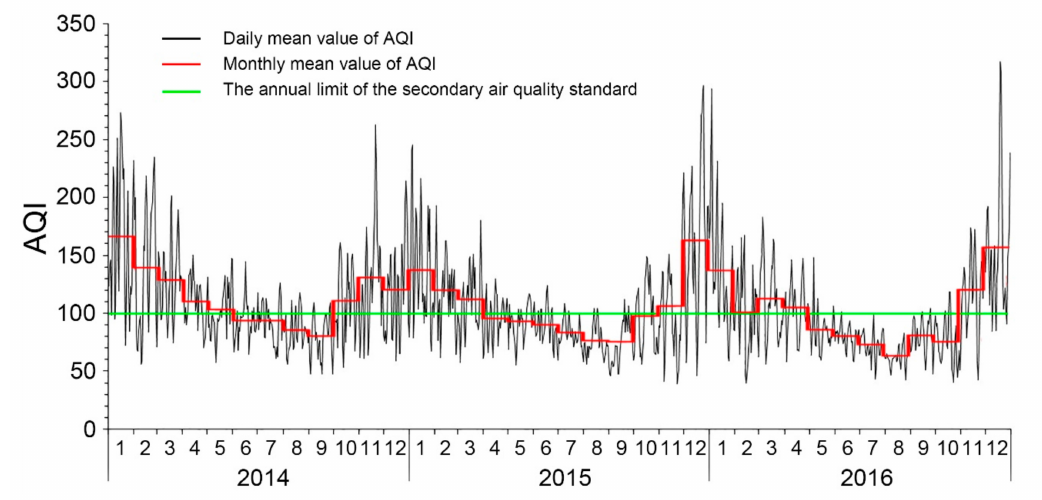
Figure 4. Daily and monthly average values of AQI for the cities of North China (2014–2016).